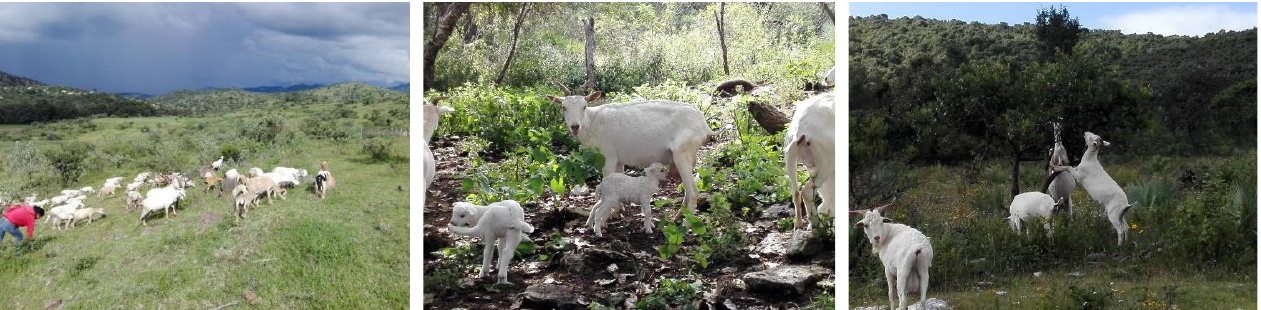
Figure 2. Transhumance systems in southern Mexico are distributed in dry, semi-arid and mountainous large areas (left). In this system, the shepherd herds the goats from coastal regions to mountainous regions such as Tehuacán, Puebla or to Huajuapan de León, Oaxaca. These animals are raised for the annual festival of Mole de caderas celebrated every autumn. One of the main breeds used in this system is the Mexican Pastoreña Goat ( Blanca Pastoreña ) (middle), which is well-adapted physiologically and anatomically to graze and browse in harsh environmental, orographical, and climate conditions (right).